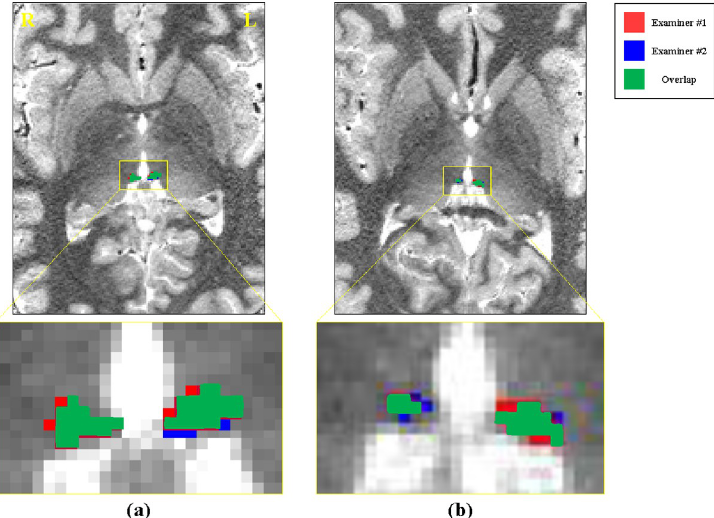
Fig 2. The right and left overlapping habenula in an (a) HC and (b) MDD patient on an axial ME-MP2RAGE T1 map segmented by Examiner #1 and Examiner #2. Red, blue, and green indicate the voxels segmented by Examiner #1, Examiner #2, and the overlap of voxels identified by both examiners, respectively. Abbreviations: R, right; L, left; HC, healthy control; MDD, major depressive disorder; ME-MP2RAGE, multi-echo magnetization-prepared 2 rapid gradient